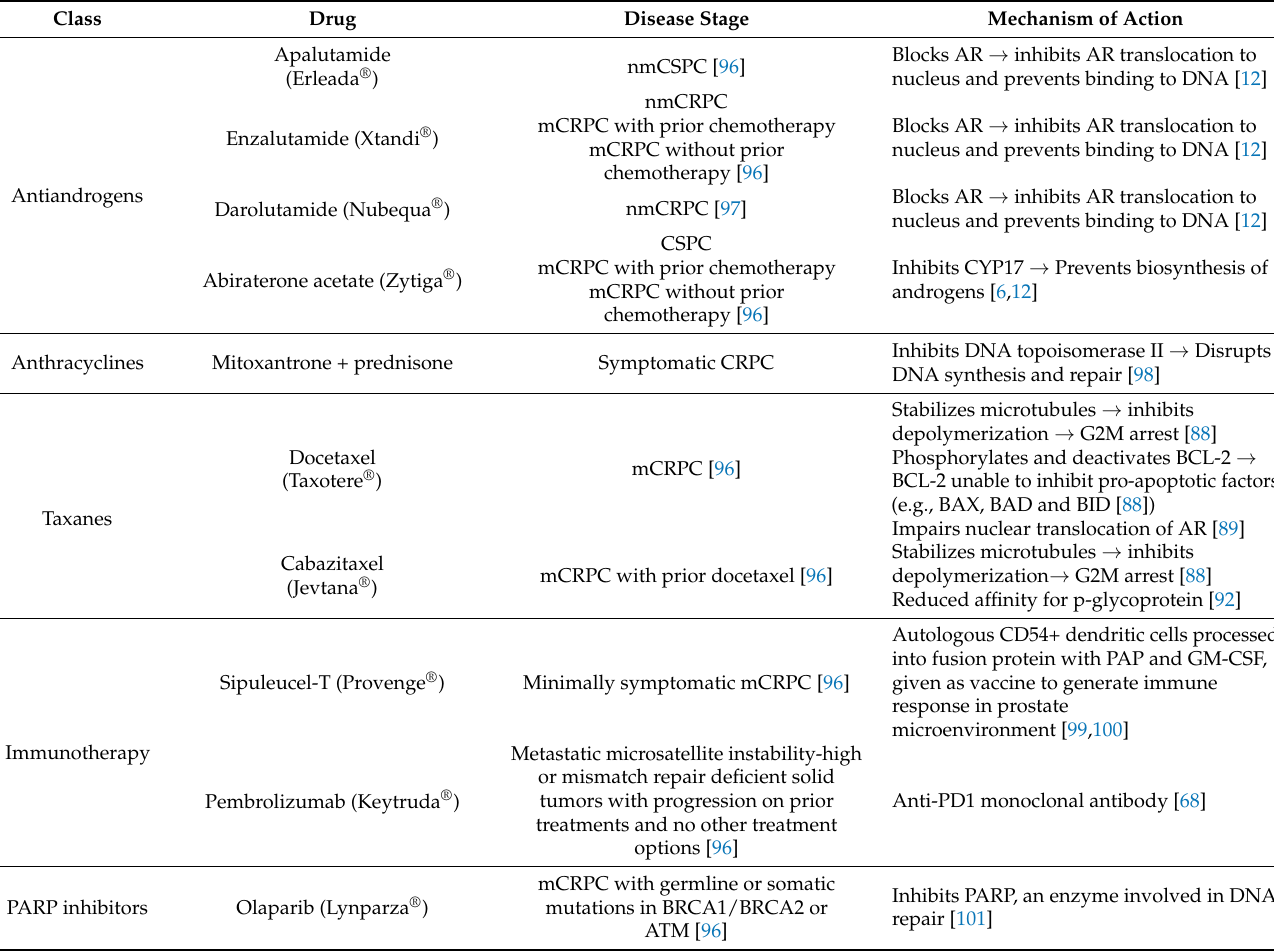
Table 2. Current Treatment Modalities for Advanced Prostate Cancer and their Mechanisms of Action. Pharmacological targeting of advanced prostate cancer. Pharmacological targeting of advanced prostate cancer: hormone-sensitive prostate cancer (HSPC), castration-resistant prostate cancer (CRPC), and metastatic